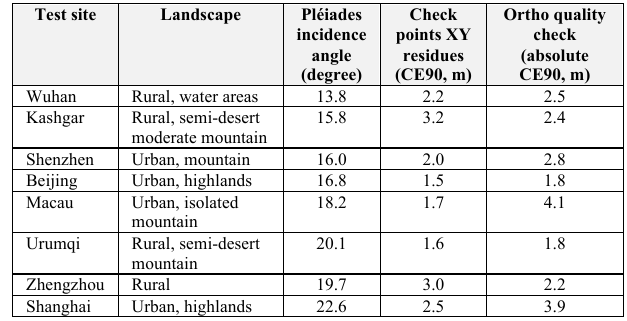
Table 4. Accuracy assessment on China test